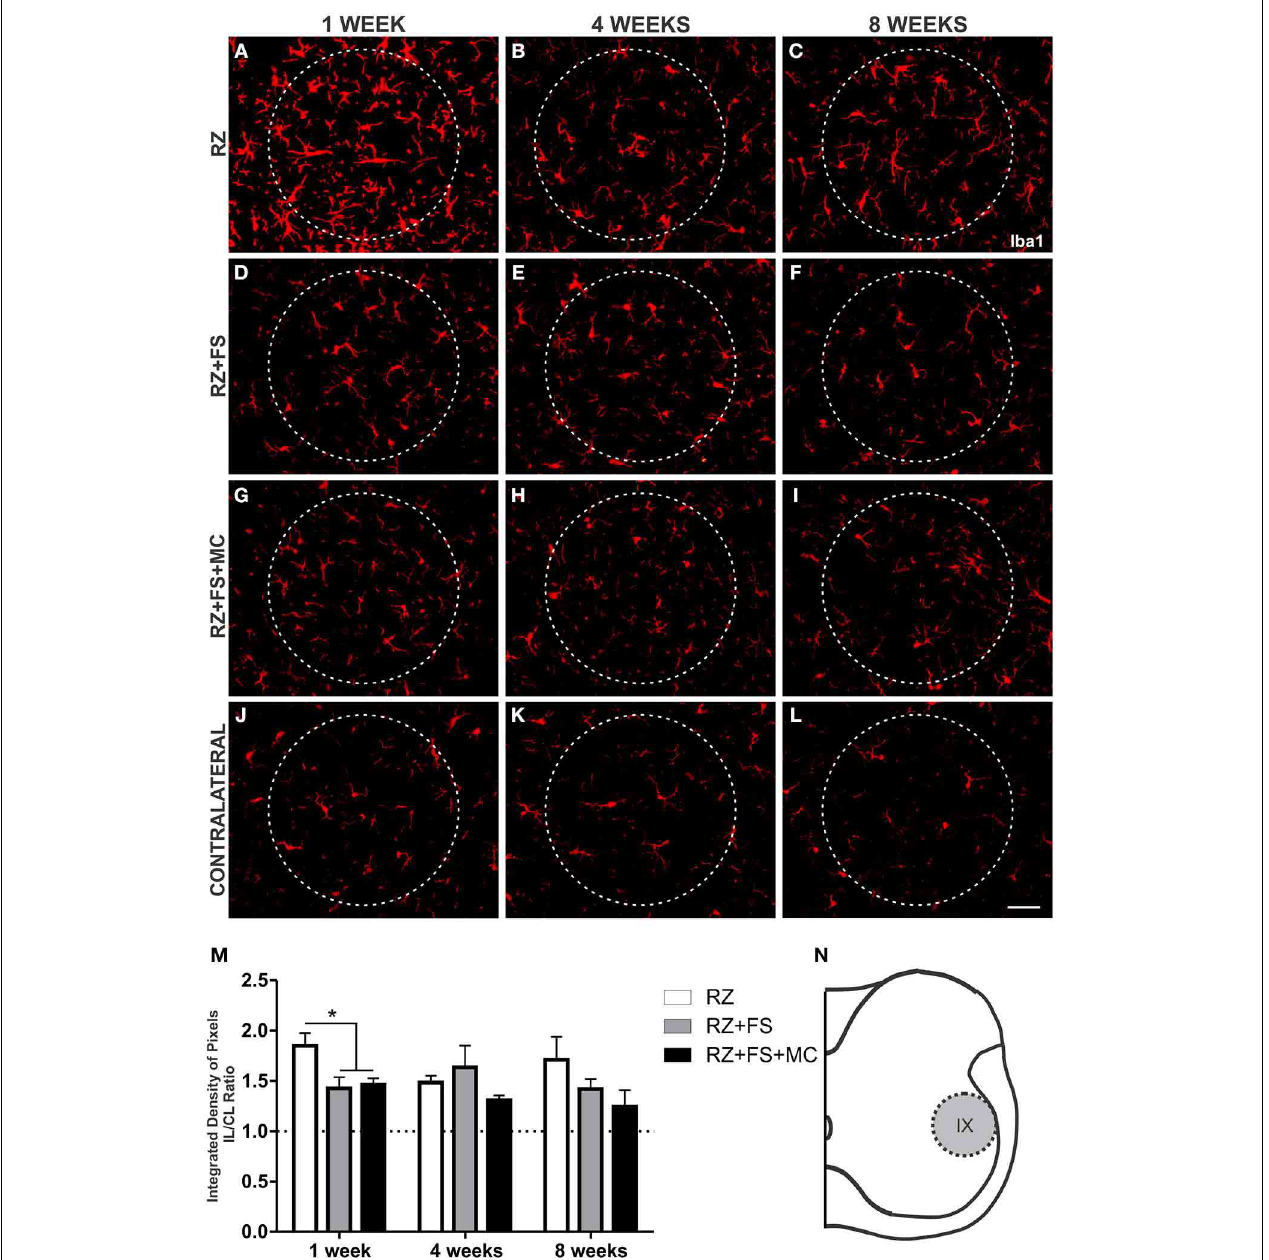
FIGURE 7 | Immunohistochemistry for ionized calcium binding adaptor protein (Iba1). (A–L) Representative images of RZ, RZ + FS and RZ + FS + MC, 1, 4, and 8 weeks post lesion. (M) Quantification (ratio IL/CL) of the integrated density of pixels, obtained in the region